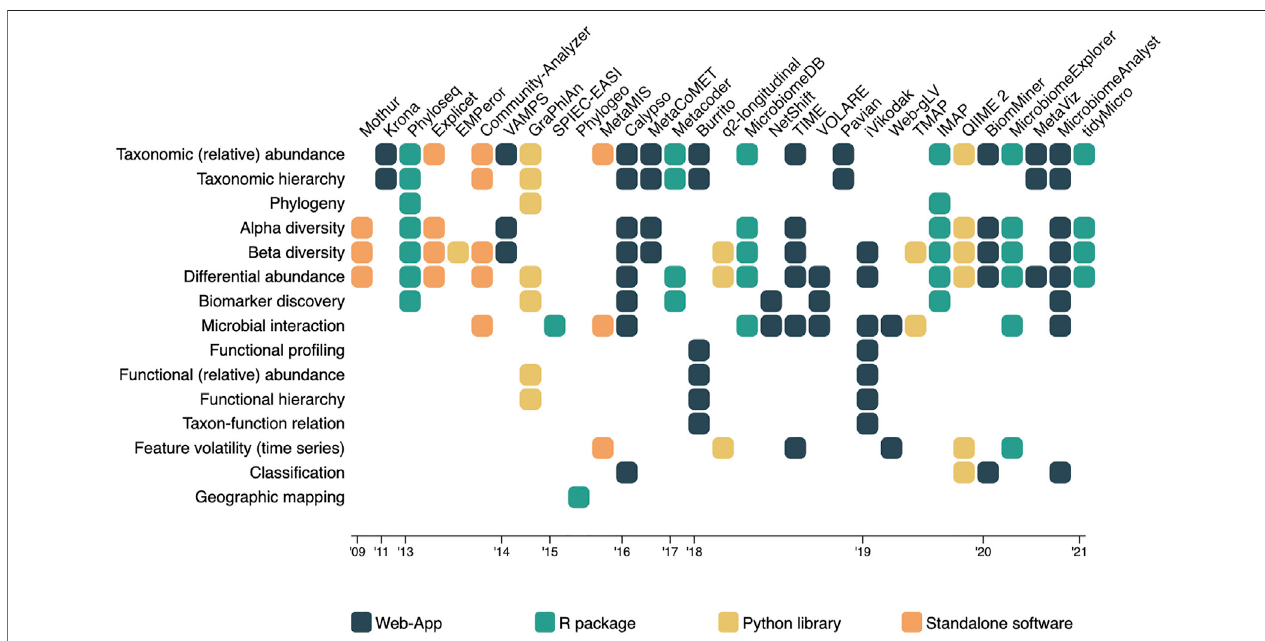
FIGURE2| Amatrixoverviewofthetoolsandalgorithmsincludedintheliteraturereview,inwhichthetoolsandalgorithmsarerepresentedinthecolumns,andthe microbiomeaspectstheymeasureandpresentlistedasrows.Cellsindicatethecoverageofanaspectbythecorrespondingtool,andarecoloredbasedontheplatform they were hosted